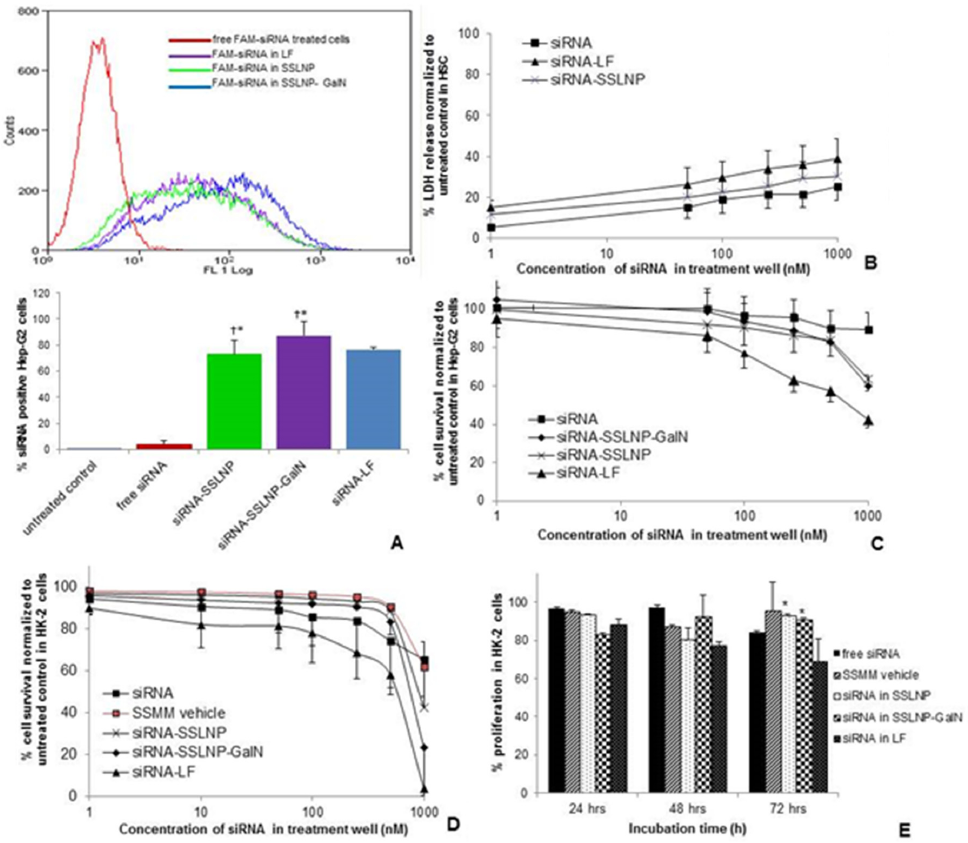
Figure 4. Cell uptake and cytotoxicity assays: ( A ) Hepatic Hep-G2 cell uptake of FAM-labeled siRNA in various complexes. Changes in FACS histogram indicative of siRNA positive cells (upper), bars represent quantitative analysis of FACS histogram as a percentage siRNA-positive cells